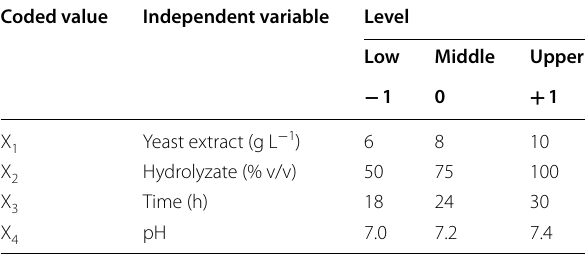
Table 1 Independent variables with their respective coded values and levels used in the Box–Behnken design Coded value Independent variable